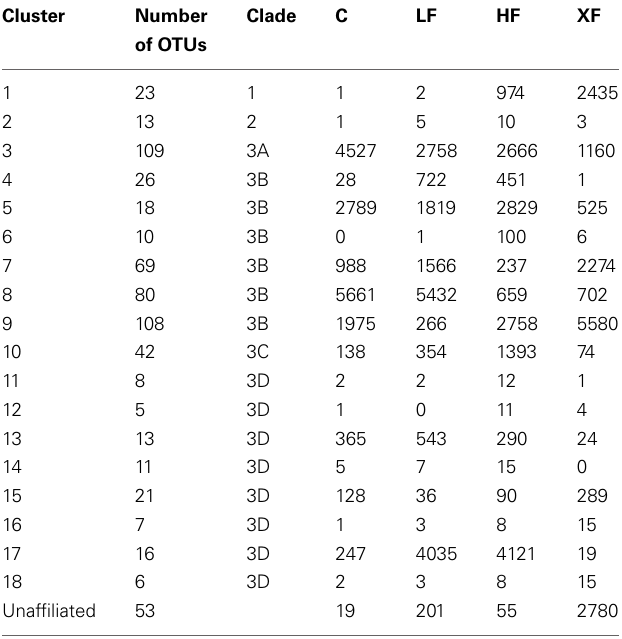
Table 2 | Summary of the phylogenetic distribution of nirS OTUs in 18 clusters represented in six clades on the phylogenetic tree (Figure 8).